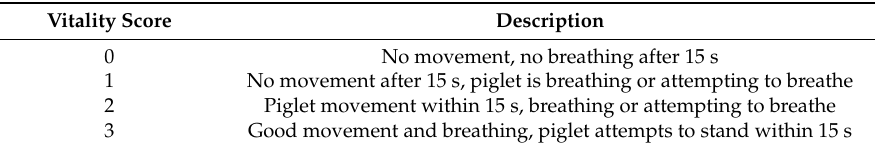
Table 1. Categorical scoring system used to subjectively estimate piglet vitality immediately following birth